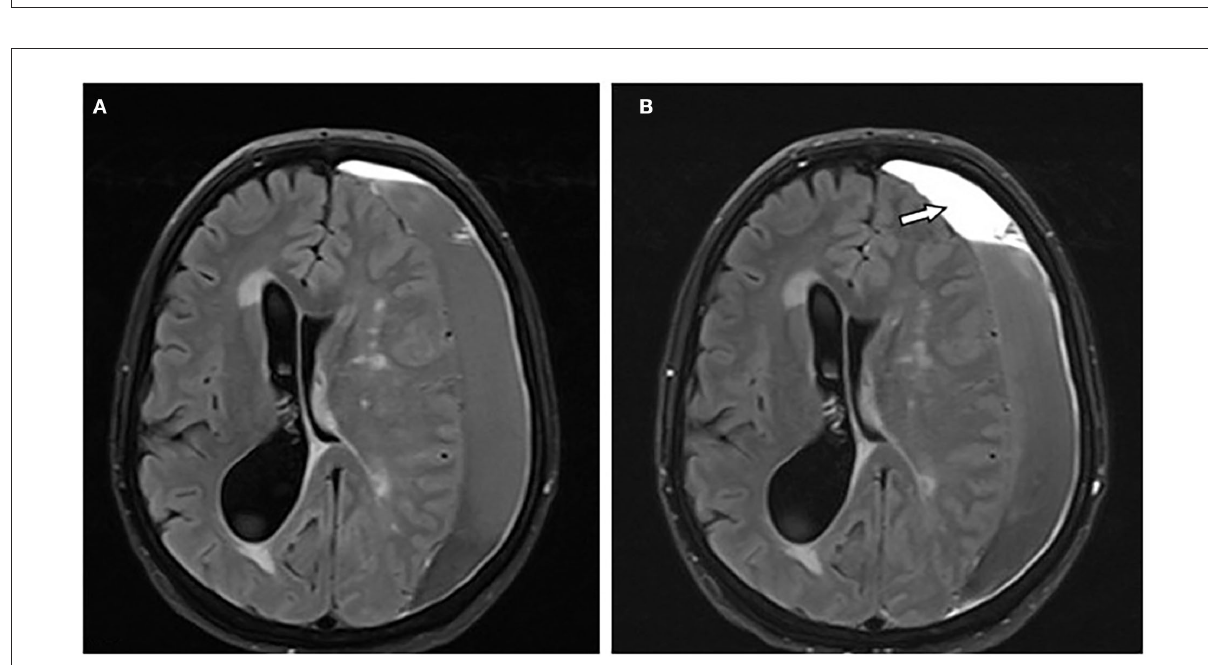
FIGURE4 A 66-year-old female patient with chronic subdural hematoma (cSDH) over the left convexity. Axial T2-FLAIR images before (A) and after (B) contrast administration showing mass-like enhancement of the hematoma [ (B) :